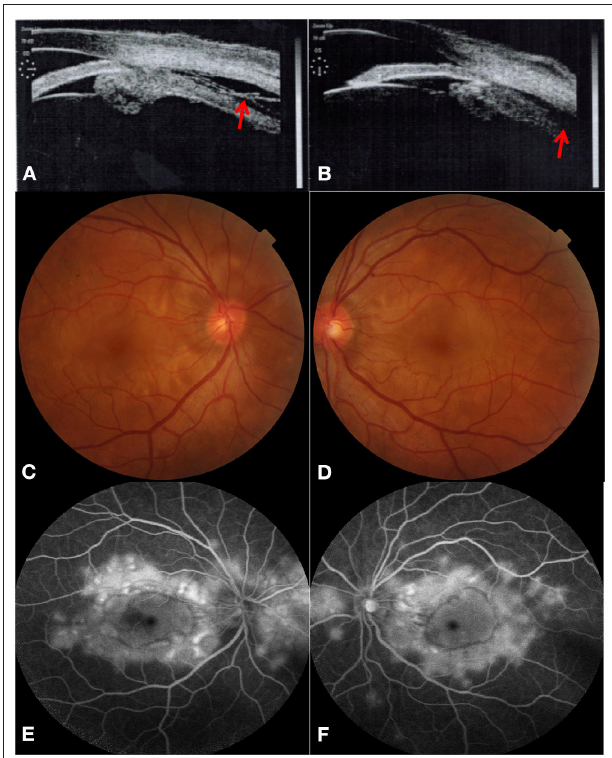
FIGURE 1 | Acute angle-closure glaucoma secondary to Vogt-Koyanagi-Harada disease at initial visit. Ultrasound biomicroscopy revealed both leakage (red arrow) and forward rotation of the ciliary body and secondary angle-closure in bilateral eyes [ (A) right eye, (B) left eye]. Color fundus photograph showed multifocal serous retinal detachments with hyperaemic optic discs in both eyes [ (C) right eye, (D) left eye]. Typical “multiple lake” hyperfluorescence and optic disc leakage are found in the late stage of fundus fluorescein angiography [ (E) right eye, (F) left